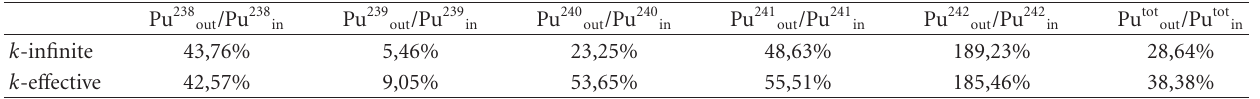
Table 4: Pu out /Pu in for k -infinite and k -e ff ective models.